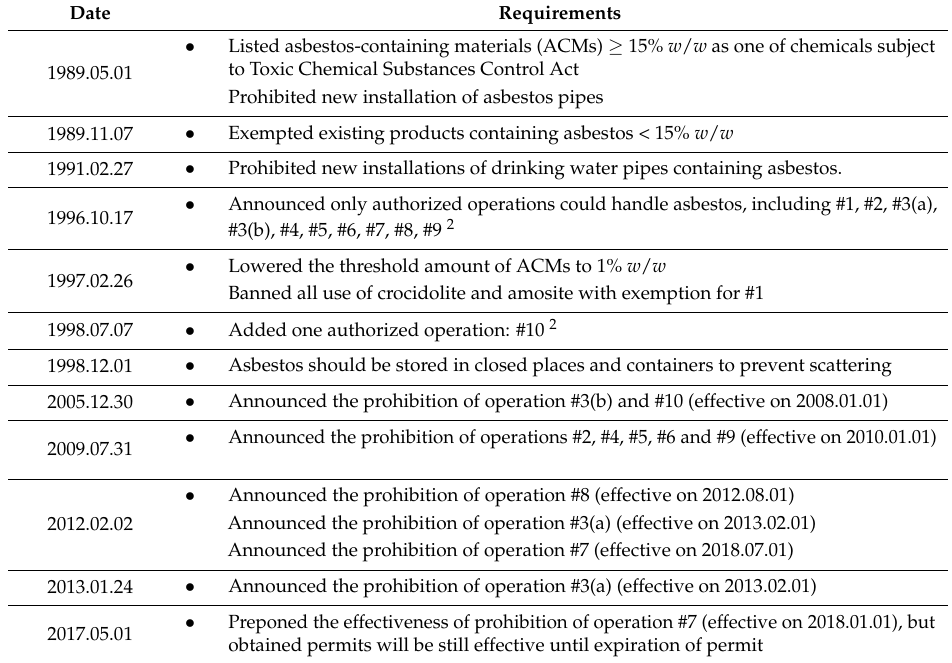
Table 1. Regulations covering asbestos authorization and prohibition in Taiwan 1